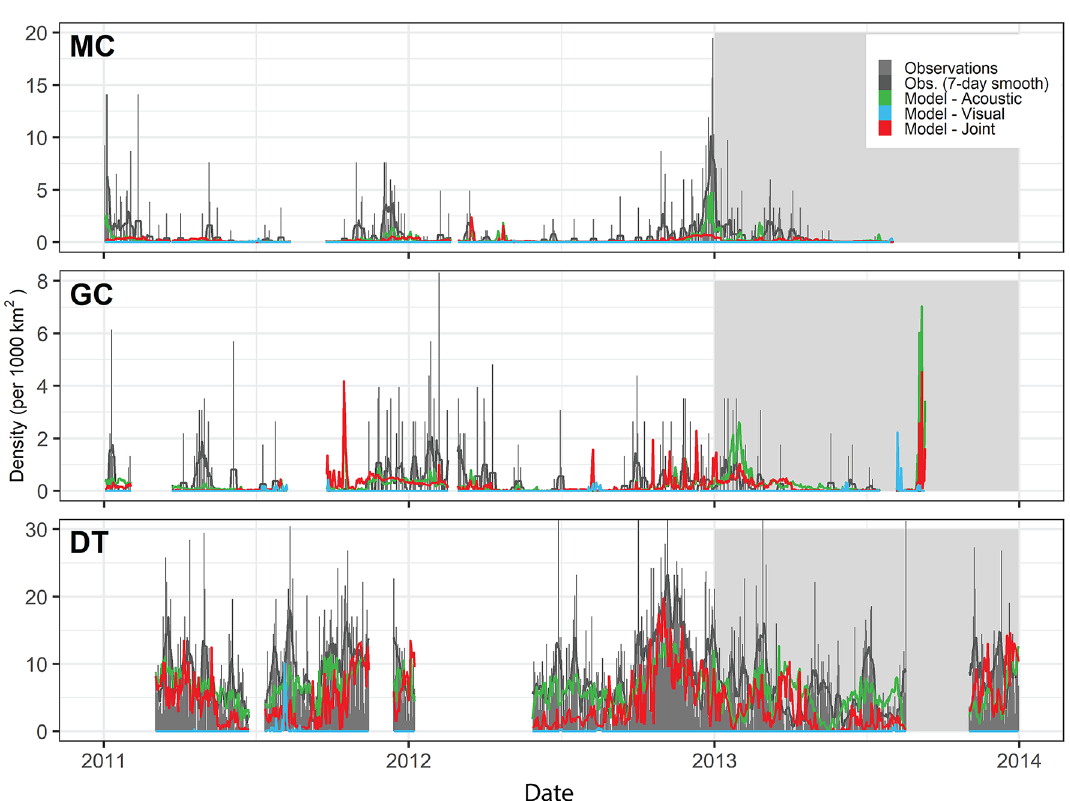
Figure 4. Time series of daily observed and neural network model-predicted Cuvier’s beaked whale densities from the passive acoustic monitoring sites MC, GC, and DT. Gray bars indicate observed daily density estimates. Lines indicate neural network model predictions (Blue: Acoustic only, Green: Visual only, Red: Joint) on training (white background) and test (gray background) datasets. The acoustic only model best predicted the test data based on RMSE. Time series gaps represent periods when no PAM data was being collected at the